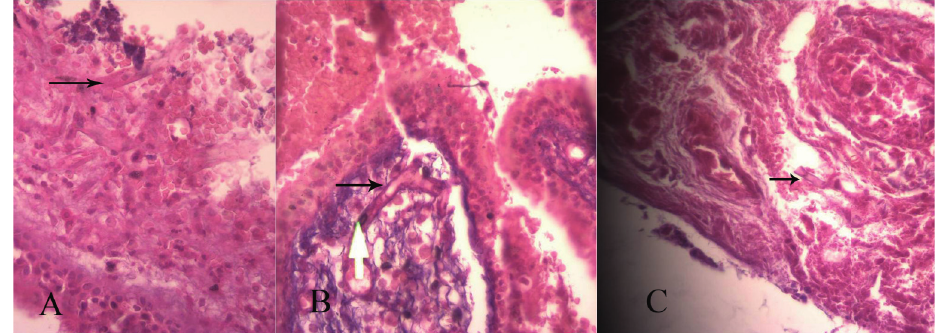
Figure 3: (a–c) Tissue biopsy of sinonasal tissue showing infiltration of inflammatory cells and broad-based fungal hyphae (black arrows), diagnostic for mucomycosis. Table 1: Summary of reports on the four cases with COVID-19, DKA, and